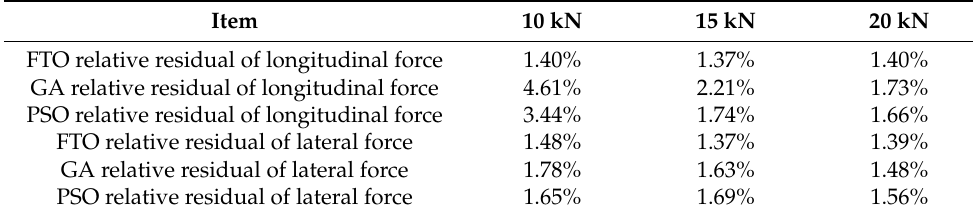
Table 1. First-level parameters identification